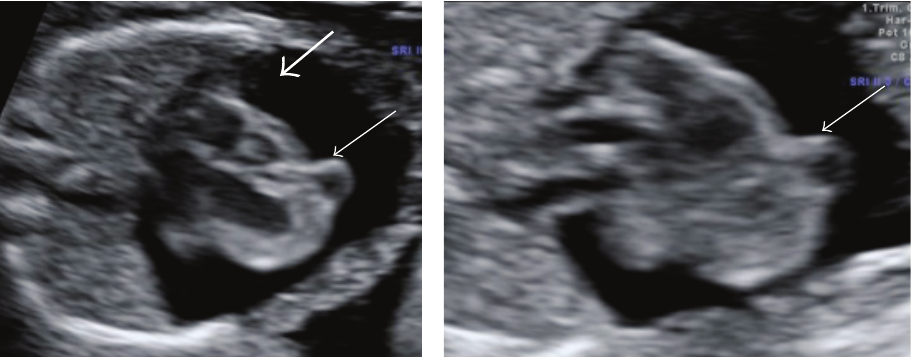
Figure2:Transversalviewofthethoraxduringthe16thweekofpregnancy.Severepericardialeffusion(thickarrow)andcardiacdiverticulum in the ventricular apex that connects with the ventricle (thin arrow) can be